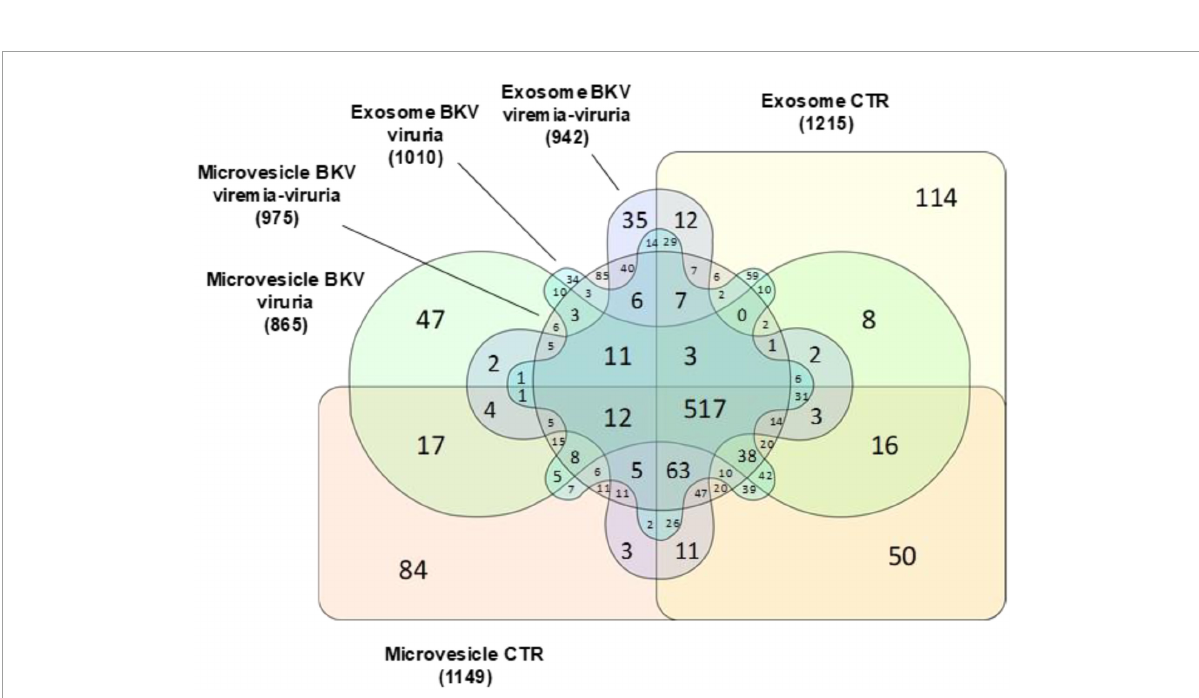
FIGURE5 Venn diagram of total proteins identified in microvesicles and exosomes stratified in patients with BKV viremia-viruria, BKV viruria and control (CTR). Venn diagram shows the distribution of the total proteins identified as well as the common and exclusive proteins in urinary microvesicles and exosomes isolated from patients with BKV viremia-viruria, BKV viruria and CTR. The numbers represent the distinct proteins in the overlapping and non-overlapping areas. Among the proteins identified, 47, 34, 85, and 35 were exclusively found in microvesicles of KTRs with BKV viruria, exosomes of KTRs with BKV viruria, microvesicles of KTRs with BKV viremia-viruria and exosomes of KTRs with BKV viremia-viruria,